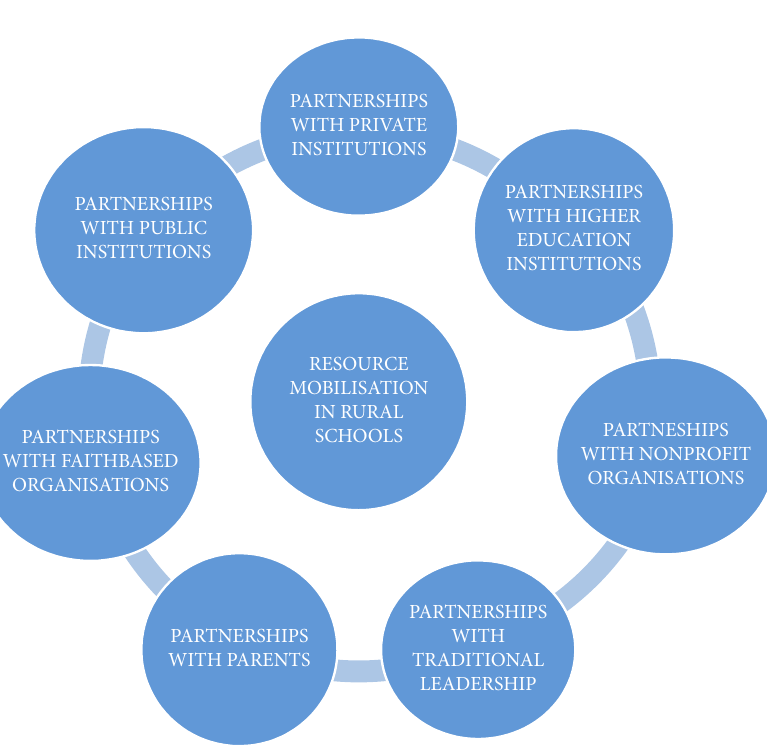
Figure 17: Rural school-community